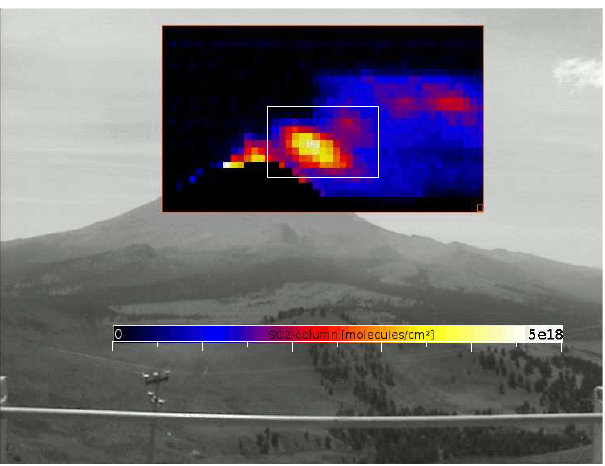
Fig.10. AtypicalSO 2 plumefromPopocat´epetlvolcanomeasuredfromtheAltzomonisiteon17March2006. Fig. 10. A typical SO 2 plume from Popocat´epetl volcano mea- The slant column densities can be obtained with the on-line evaluation software after proper radiometric cali- sured from the Altzomoni site on 17 March 2006. The slant column brationandplumetemperatureestimation. TheSO 2 amountofasinglepuffinthewhiterectanglecorresponed densities can be obtained with the on-line evaluation software after toanestmatedmassof( 4 ± 1 )t. proper radiometric calibration and plume temperature estimation. The SO 2 amount of a single puff in the white rectangle corresponed to an estmated mass of (4 ±